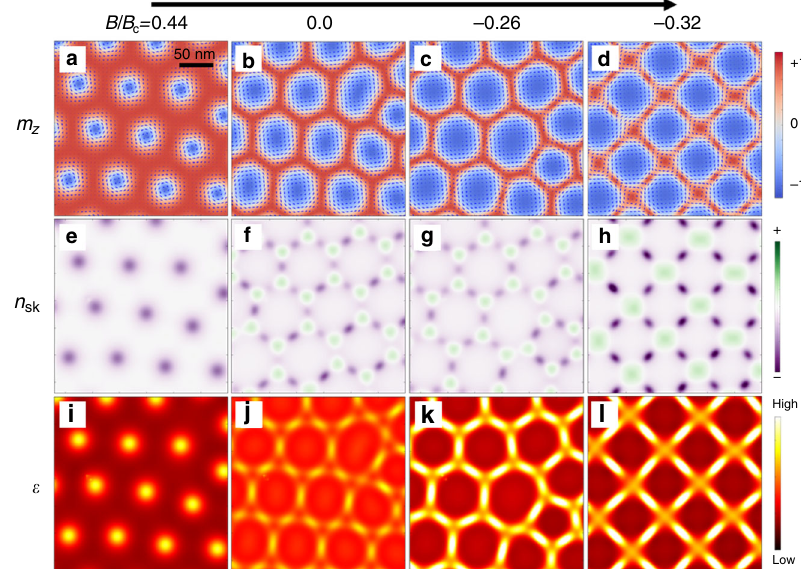
Fig. 3 Magnetic- fi eld-induced structural transition of metastable skyrmion lattice calculated by micromagnetic simulations. a – d The distribution of local magnetization m in the fi eld-decreasing process from the triangular SkL state in a . The arrows correspond to the in-plane component of local magnetization and the background color represents the out-of-plane component of local magnetization ( m z ). e – l Contour map of ( e – h ) topological charge density ( n sk ) and ( i – l ) the energy density ( ε ) corresponding to a – d .